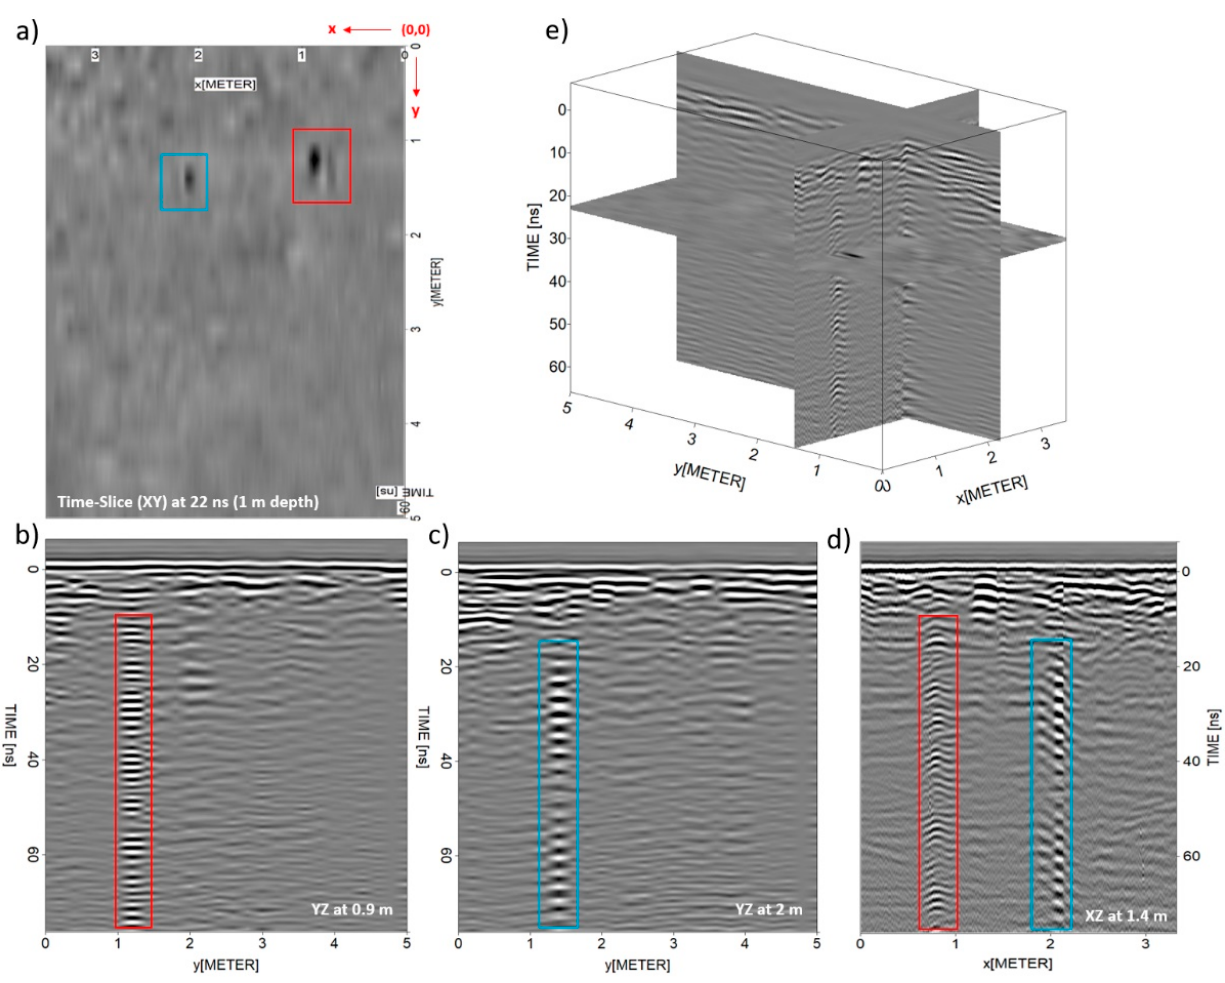
Figure 4. 500 MHz data: time-slice or XY image at 1 m depth ( a ), YZ image at 0.9 m in x -line ( b ), YZ at 2.0 m in x -line ( c ), XZ or conventional radargram at 1.4 m in y -line ( d ), and 3D perspective ( e ).